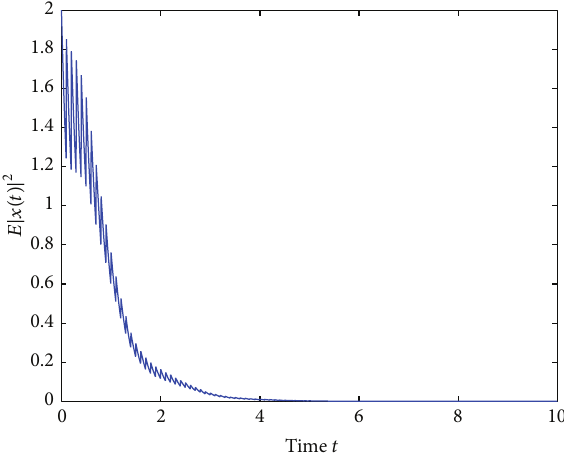
Figure 3: The mean square of the solution without external input (2000